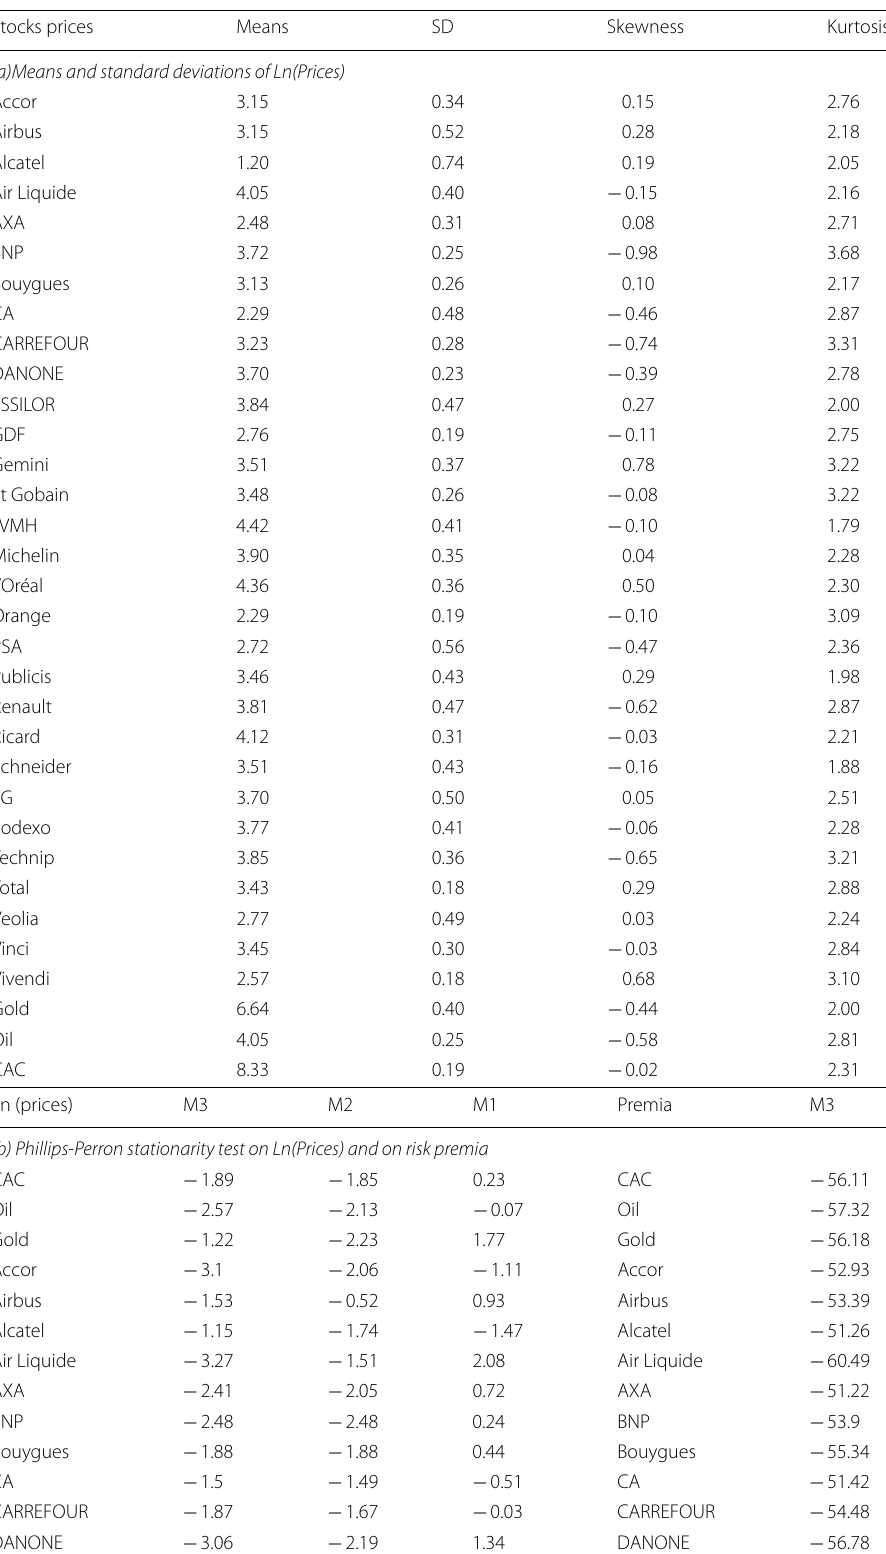
Table 7 Equities